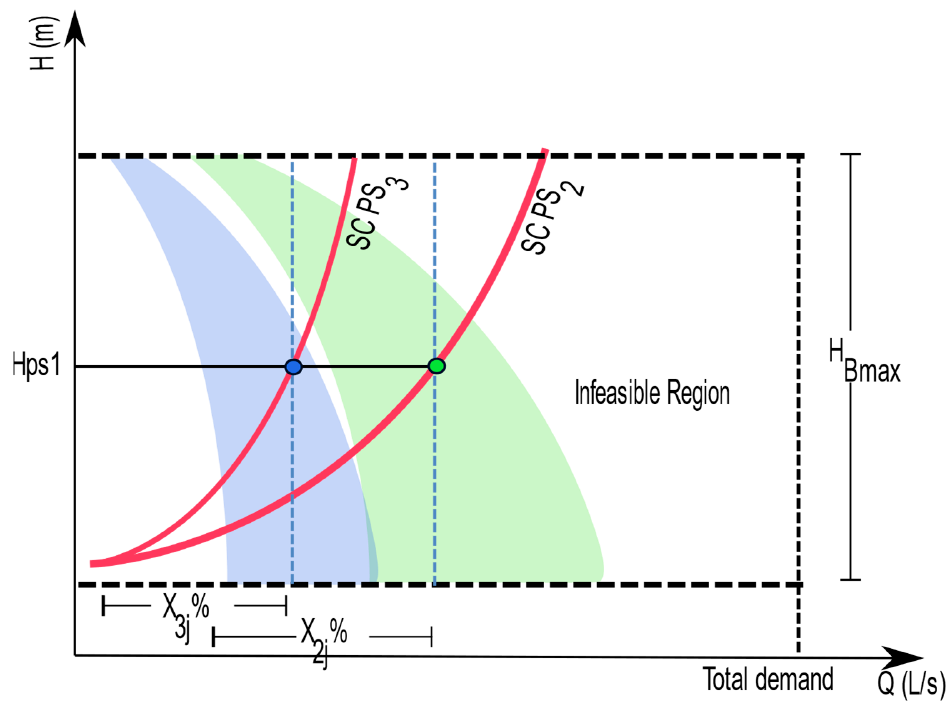
Figure 2. Decoding a solution for a 2-PS problem.